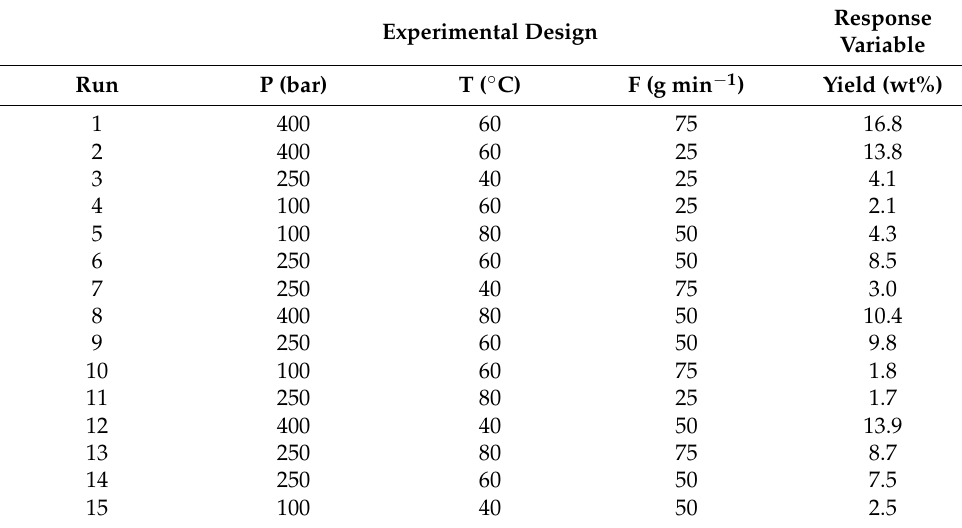
Table 4. BBD matrix and response values obtained for TSO extracts by SFE-CO 2